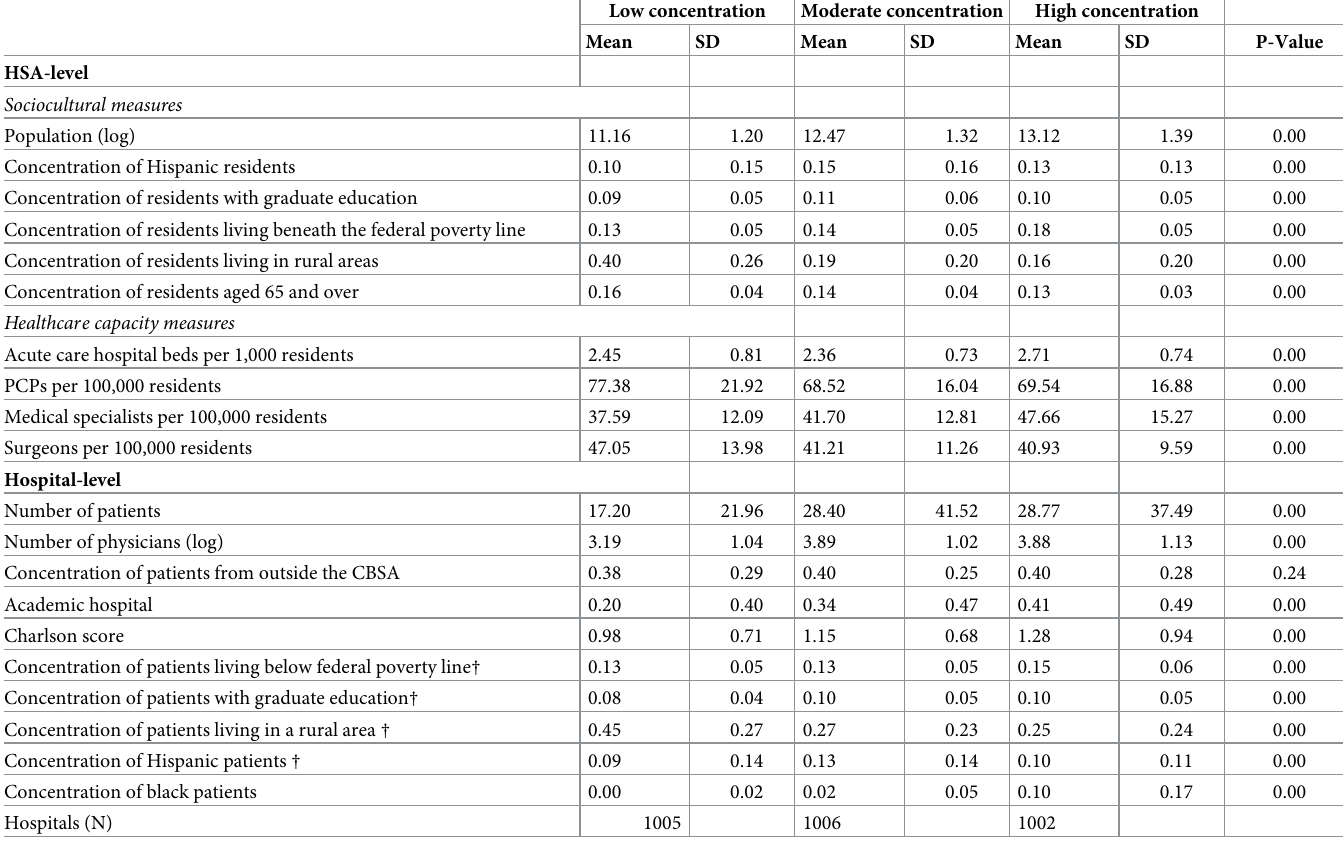
Table 1. Characteristics of HSAs and anchor hospitals in 2011, stratified by the concentration of black